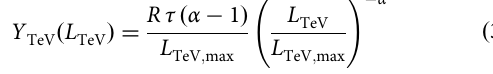
Table 1. The index β GeV is instead determined by requiring